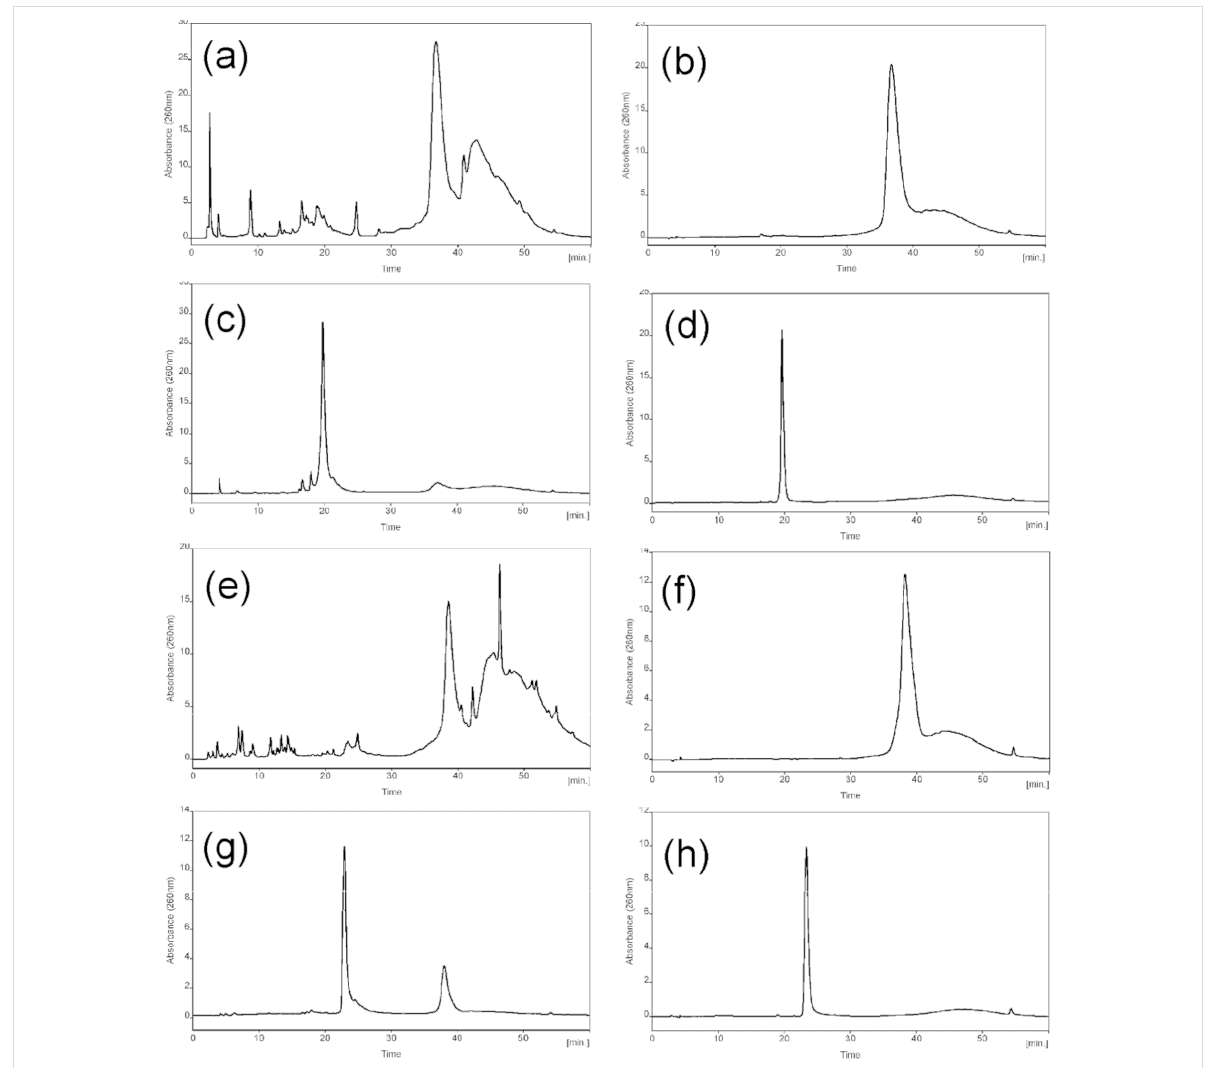
Figure 4: RP HPLC profiles of (a) crude 30a-tr , (b) pure 30a-tr , (c) crude 30a , (d) pure 30a , (e) crude 30c-tr , (f) pure 30c-tr , (g) crude 30c , (h) pure 30c . In profiles (a) and (e), the well-separated major peak before 40 minutes is the trityl-tagged full-length ODN. The peaks after 40 minutes are branched sequences with two or more trityl tags.